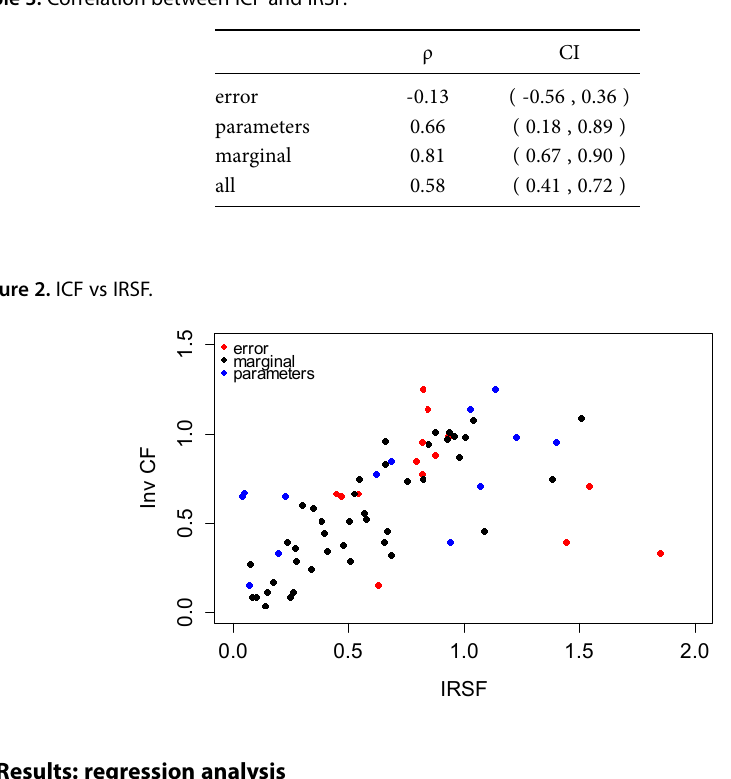
Table 3. Correlation between ICF and IRSF.